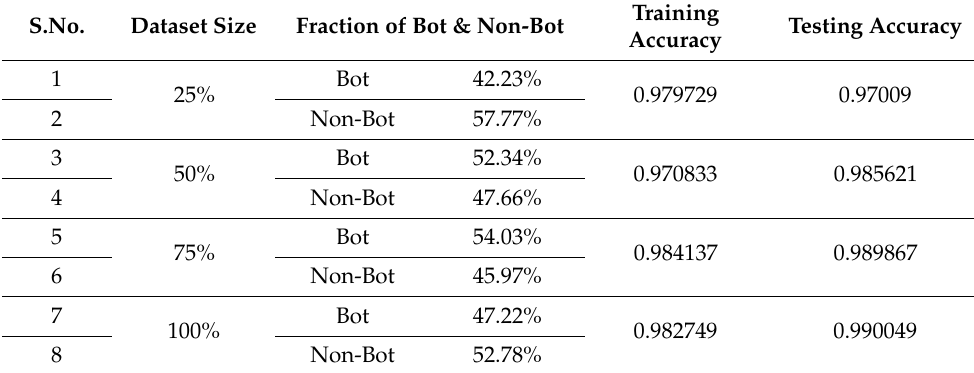
Table 2. Accuracy of Machine Learning Classifiers & Proposed TweezBot .